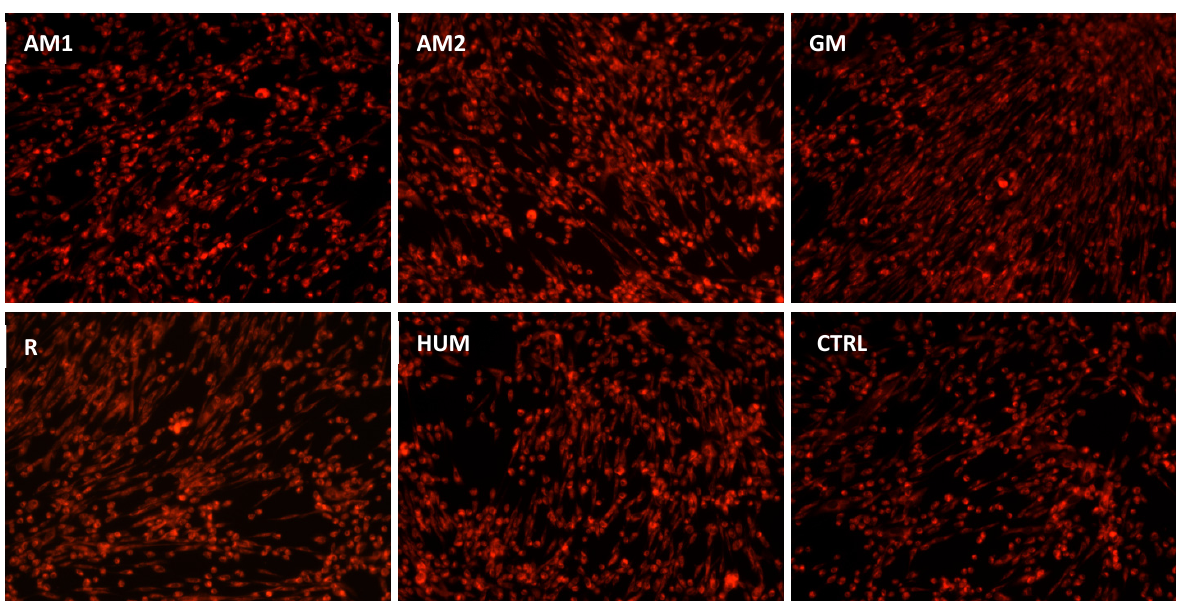
Figure 12. Fluorescence images of MG-63 cells coloured with CMTPX fluorophore in the presence of experimental PMMA bone cements.